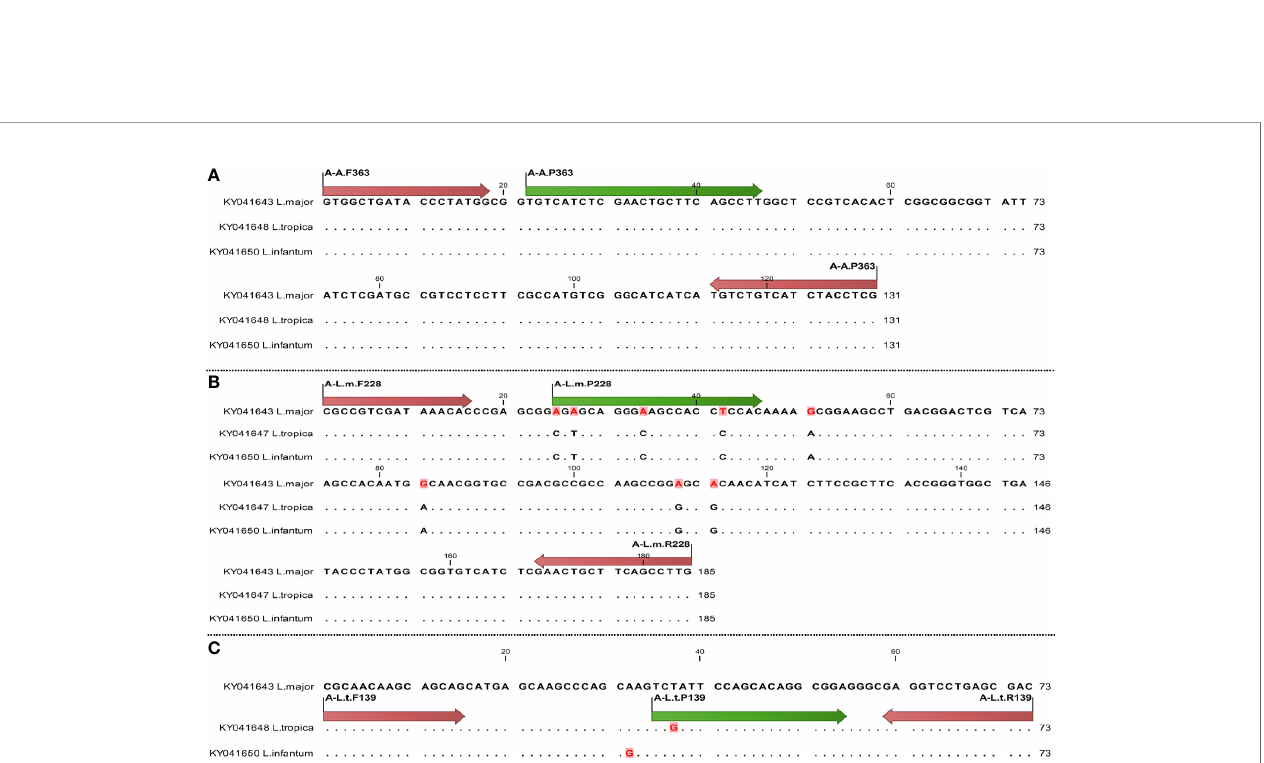
FIGURE 2 | Schematic illustration of primer and probe (nucleotide site variation) in AAP3 gene for diagnostics of Leishmania species using qPCR, arrows of start and end sites showing primer sites and internal arrows showing probe site; difference of nucleotides is speci fi ed by dot. The primer and probe sites are shown by red and green arrows, respectively. Sequences are speci fi ed by dot except different nucleotides. (A) Speci fi c primers and probes of all species; (B) speci fi c primers and probes of L. major ; (C) speci fi c primers and probes of L. tropica.